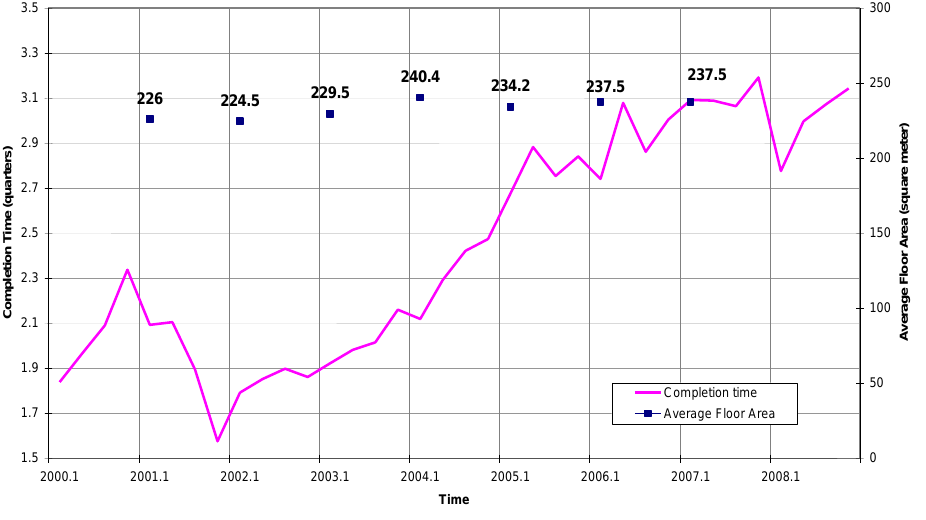
Figure 6: Average floor area and completion time in Western